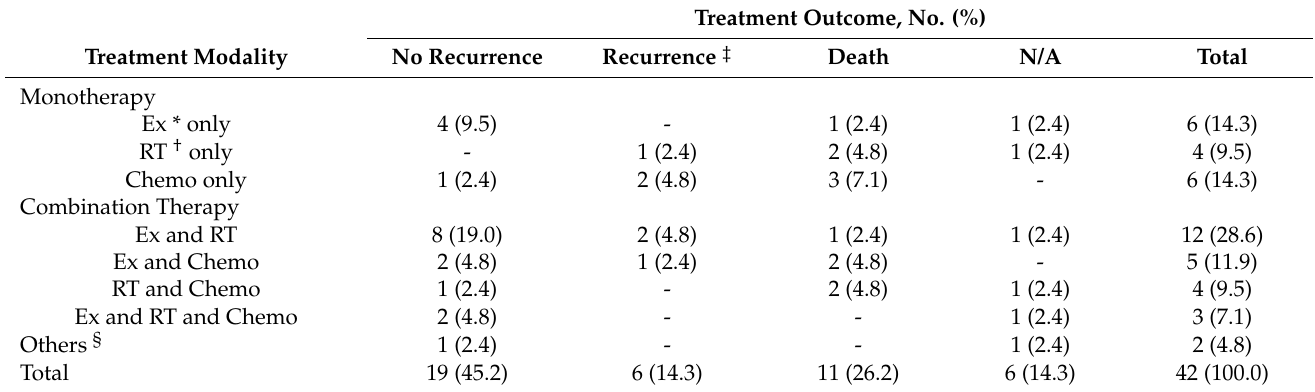
Figure 2. Follow-up period and treatment outcome of each case [5 – 36]. * Cases which clear follow-